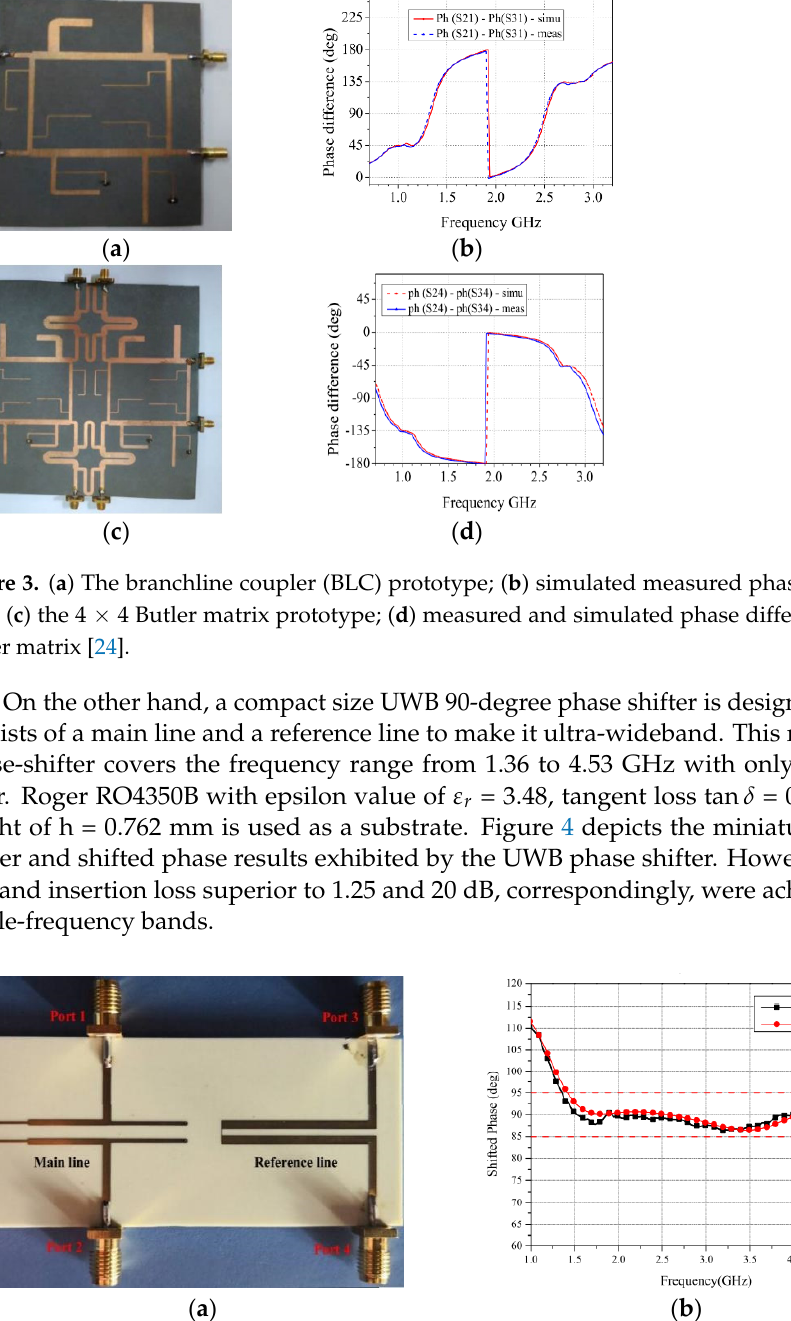
Figure 4. ( a ) The UWB phase shifter; ( b ) simulated and measured performance of the phase shifter [25].